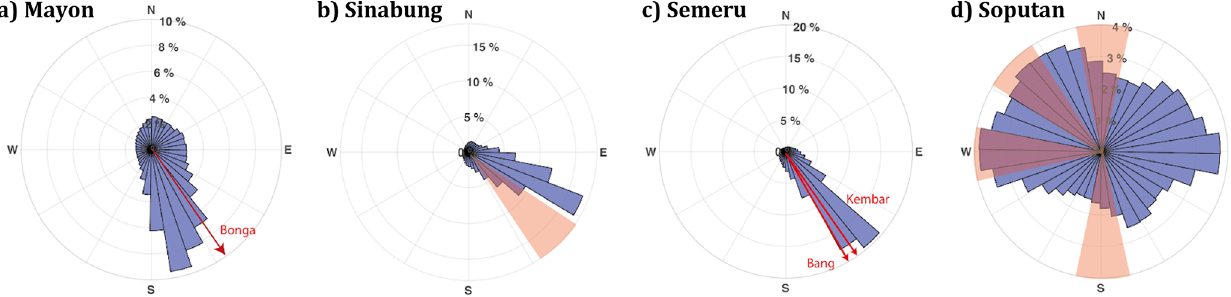
Figure 3. Probabilistic forecasting of dome collapse PDC travel directions calculated using the SRTM DEM (details in Appendices A and B). Forecasts are shown in blue with actual dome collapse PDC travel directions shown in red for the following: (a) Mayon: one dome collapse PDC on 11 June 2001 (Global Volcanism Program, 2001); (b) Sinabung: more than 100 dome collapse PDCs between 30 December 2013 and 4 January 2014 (Global Volcanism Program, 2014); (c) Semeru: several dome collapse PDCs between 30 November and 30 December 2002 (Thouret et al., 2007; Solikhin et al., 2012); and (d) Soputan: several dome collapse PDCs on 1 August and 25 October 2007 (Pallister et al., 2012). When a single channel was reported, this is shown with an arrow accompanied by the channel name, while when only a general direction was reported, this is shown as a